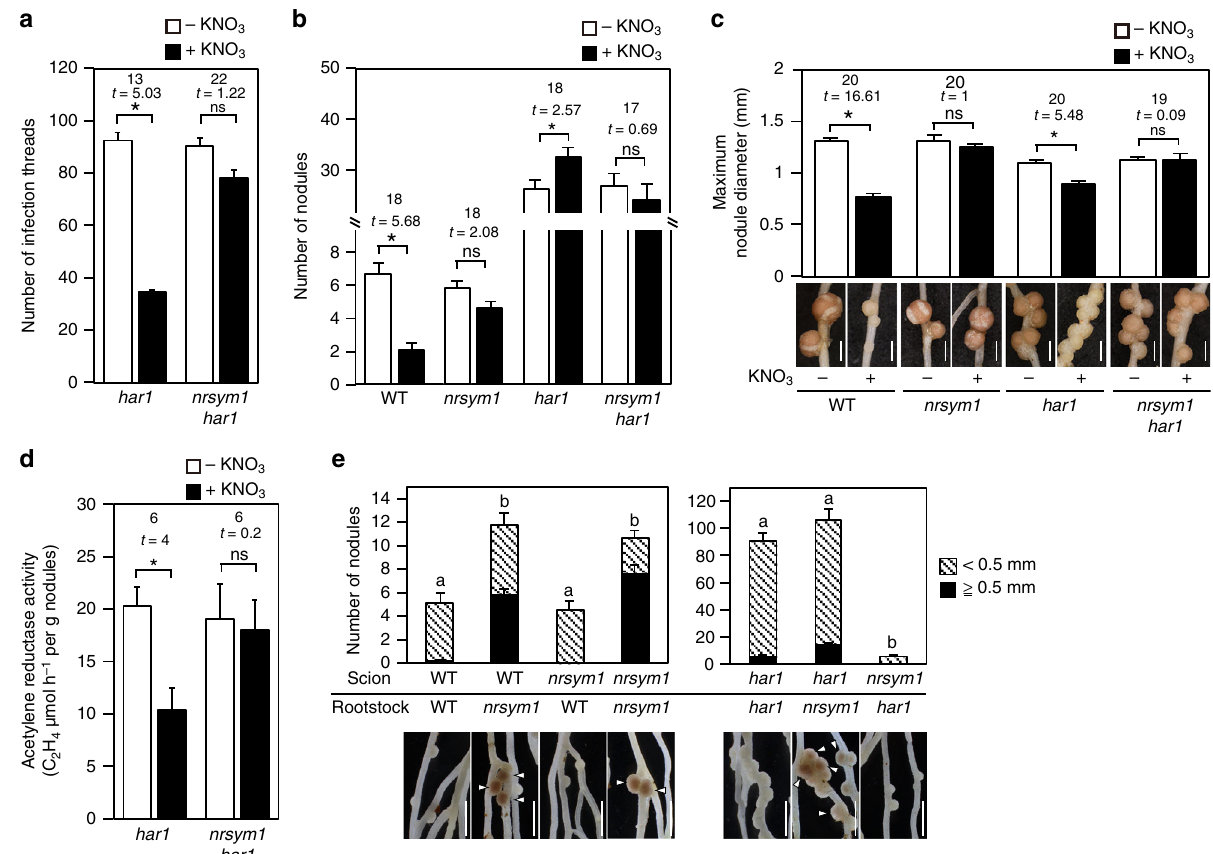
Fig. 4 Effects of nitrate on nodulation in the nrsym1 har1 double mutants. a The number of infection threads in the har1-7 mutants and the nrsym1-1 har1-7 double mutants ( n = 11 – 12 plants). Plant growth conditions were the same as those shown in Fig. 1c. b The number of nodules and ( c ) maximum nodule diameter (mm) in WT, the nrsym1-1 mutants, the har1-7 mutants, and the nrsym1-1 har1-7 double mutants grown in the presence of 0 or 10 mM KNO 3 at 21 dai ( n = 9 – 12 plants). d Acetylene reduction activity (ARA; μ mol h − 1 per g nodule) of nodules formed on the har1-7 mutants and the nrsym1-1 har1-7 double mutants ( n = 4 plants). Plant growth conditions were the same as those shown in Fig. 1e. e Nodulation and nodule numbers of plants derived from shoot – root grafts having WT, nrsym1-1 , and har1-7 genotypes. Plants were grown in the presence of 10 mM KNO 3 for 21 dai ( n = 13 plants). Arrowheads indicate mature nodules. * P < 0.05 by Student ’ s t -test. ns, not signi fi cant. Degrees of freedom are shown above the t -values ( a – d ). Columns with the same lower-case letter indicate no signi fi cant difference (Tukey ’ s test, P < 0.05; e ). Error bars indicate SEM. Scale bars: 1 mm ( c ); 2 mm ( e